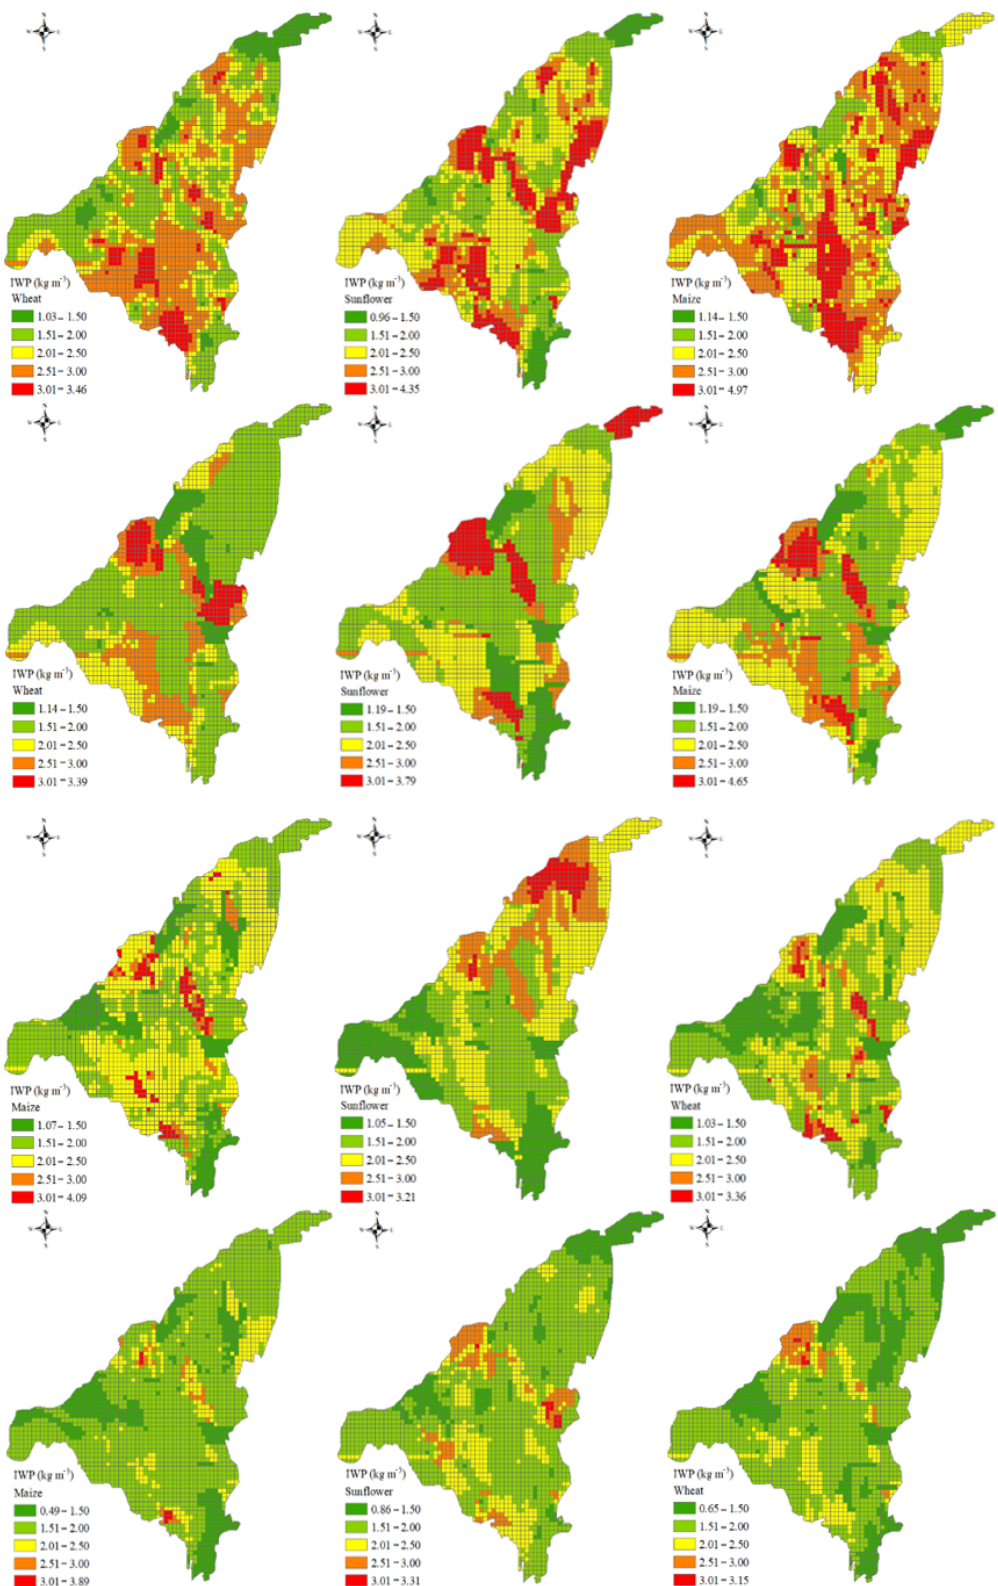
Figure 9. Spatial distribution of irrigation water productivity for the three main crops from 2006 to 2013. Each line shows the RIWP for each year in ascending order. The left, middle, and right columns show the RIWP of wheat, sunflower, and maize,